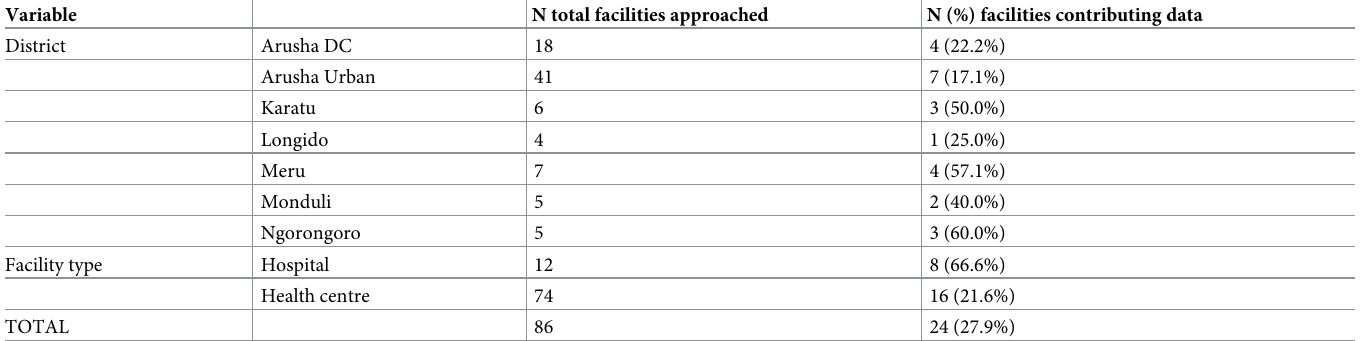
Table 1. Summary of the district location and facility type of all health facilities (n = 86) approached for participation in this study and the subset (n = 24) that con- tributed